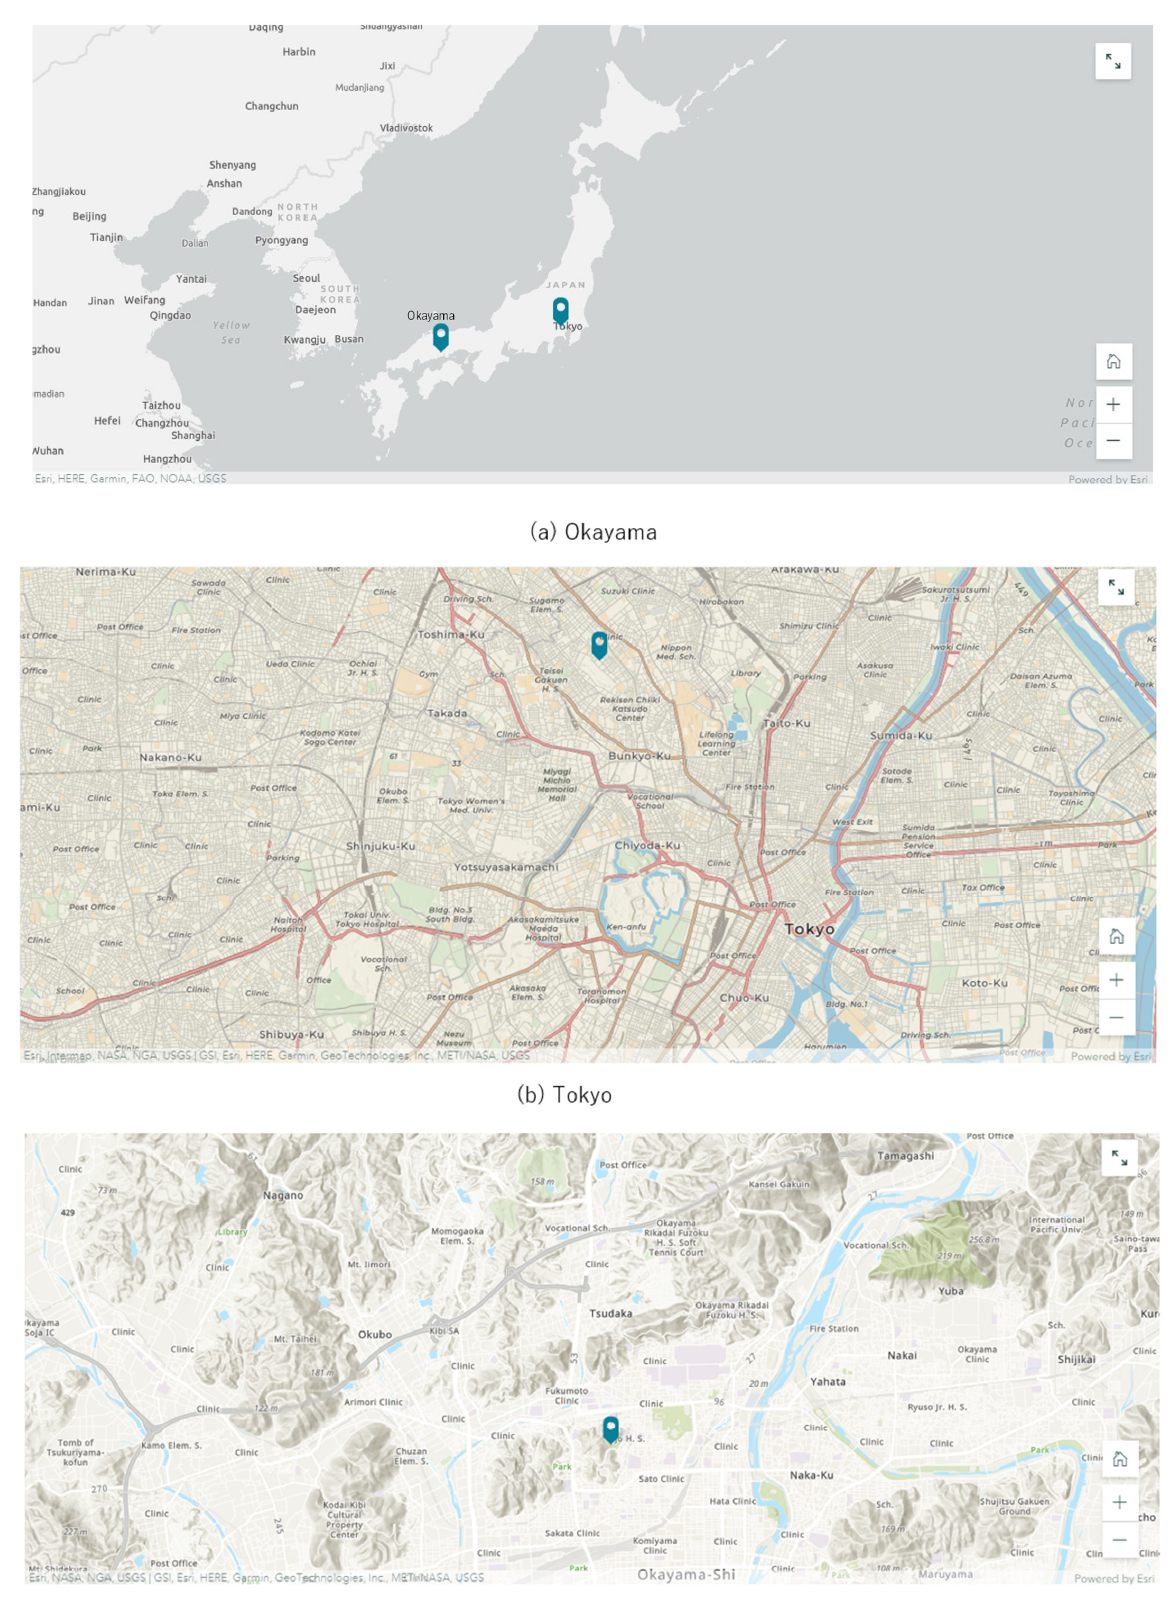
Figure 2. Outline of two ESD activities: Okayama ( a ) and Tokyo ( b ). ( a ) Kyoyama, Okayama,